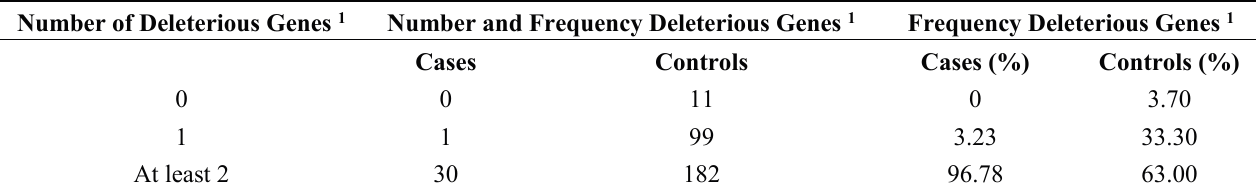
Table 4. Total number deleterious genes, number and frequency for cases and controls. Number of Deleterious Genes